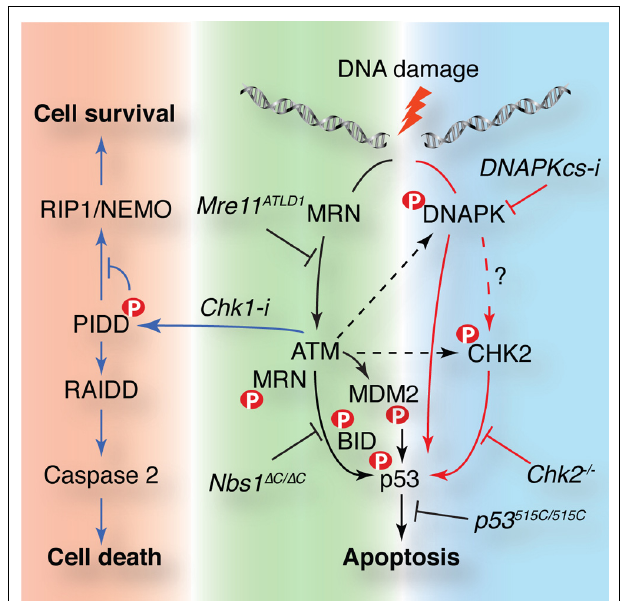
FIGURE 3 |ATM controls cellular survival in response to DNA damage through multiple pathways. DNA damage activates apoptosis in a p53-dependent manner in some cell types such as lymphocytes. p53 is activated by parallel pathways controlled by the Mre11 complex and ATM (black arrows) or DNA-PK and Chk2 (red arrows).The Mre11 complex is required for ATM activation and plays downstream roles mediating access to targets such as BID. Chk2 can act independently of ATM and may be a target of DNA-PK that is required for ATM-independent p53-dependent apoptosis. MDM2 phosphorylation by ATM is required for p53 stability and activity. ATM is also required for the Chk1 sensitized cell death pathway. ATM phosphorylates p53-induced protein with a death domain (PIDD) when Chk1 is inhibited favoring RIP associated Ich-1/CED homologous protein with death domain (RAIDD) binding that promotes caspase 2 activation and cell death. Murine alleles or small molecules (Chk1 or DNA-PKcs inhibitors) that affect these pathways are noted in italics. ATM targets are indicated with a red